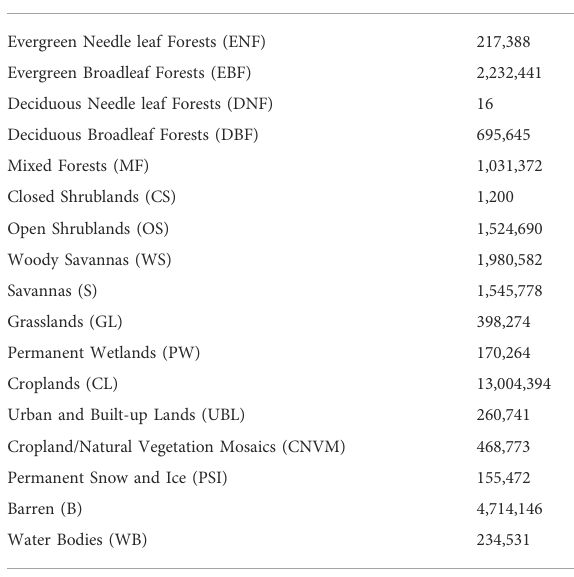
TABLE 1 Land-cover types of SEA, that were identi fi ed from MODIS (MCD12Q1) images using IGBP classi fi cations (Syed et al., 2021a).